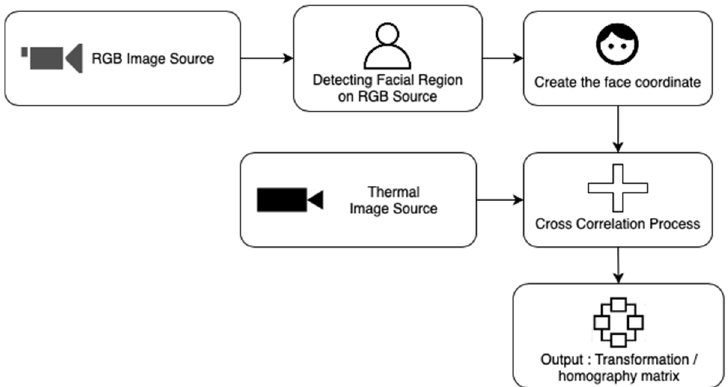
Figure 2. An overview of how RGB cameras are used to assist thermal cameras in determining ROI and the transformation process.